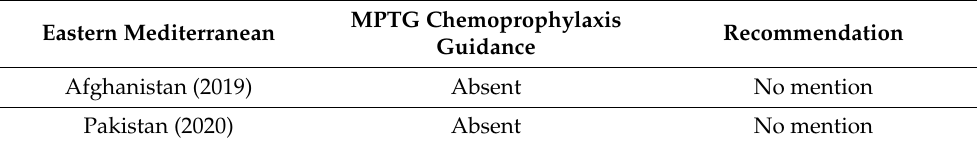
Table 4. Survey results for Eastern Mediterranean Region.